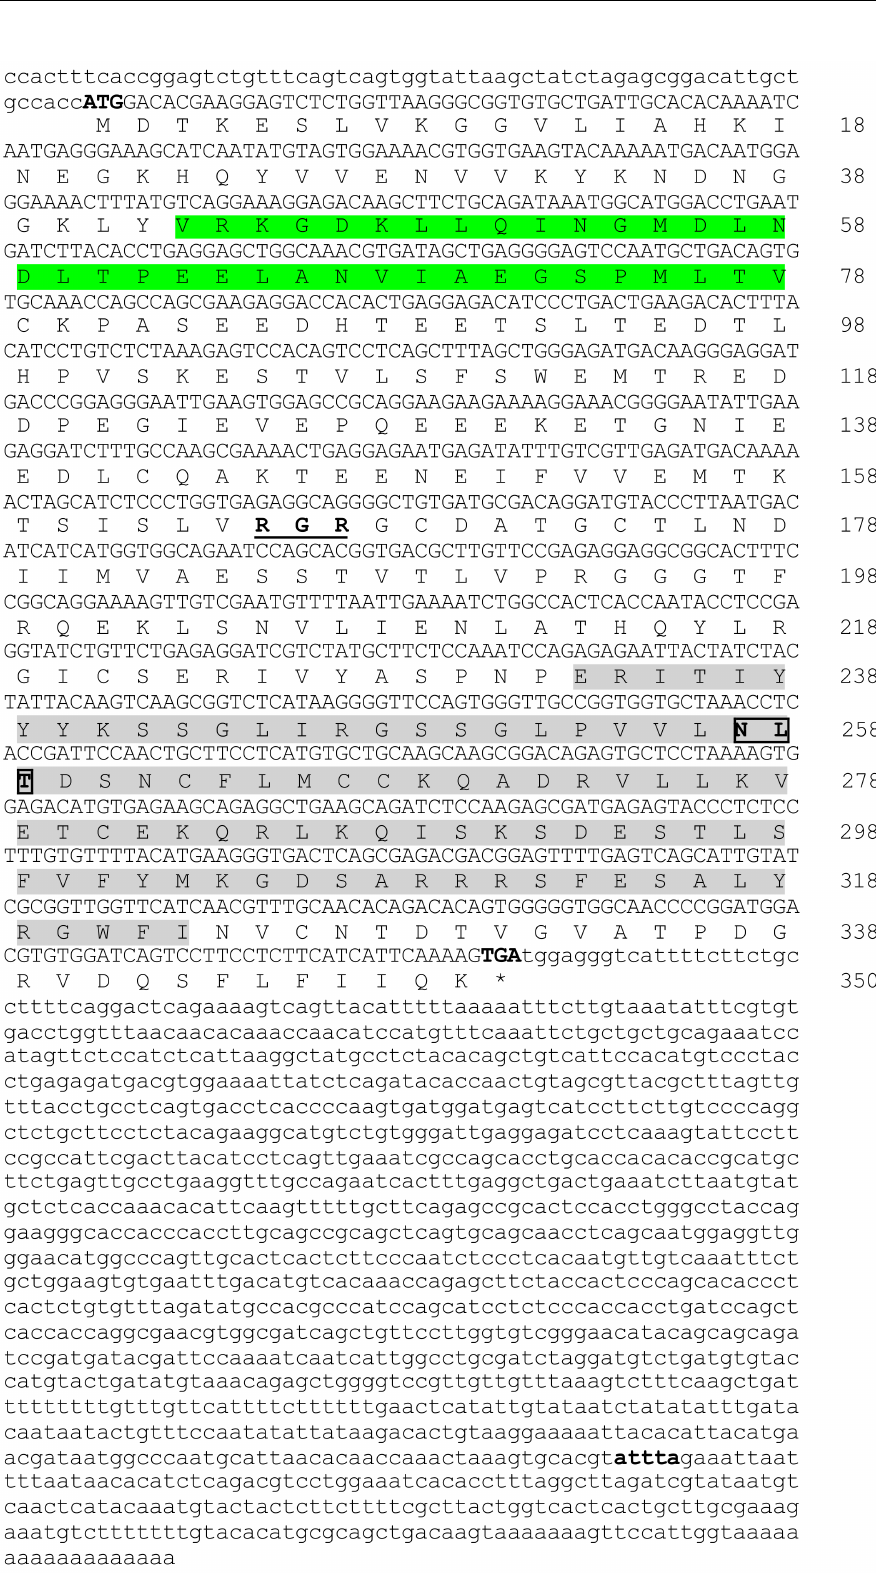
Figure 1. The structure of Nile tilapia nIL-1F. Under the nucleotide sequence, the amino acid sequence is displayed with one-letter codes. The start codon (ATG) and stop codon (TGA) are bold and asterisk (*) also represents the stop codons. The PDZ domain is shaded in green and interleukin-1 homologs is shaded in grey. The thrombin cut site (RGR) is shown in bold and underlined. The potential N-glycosylation sites (NXT) are in bold and